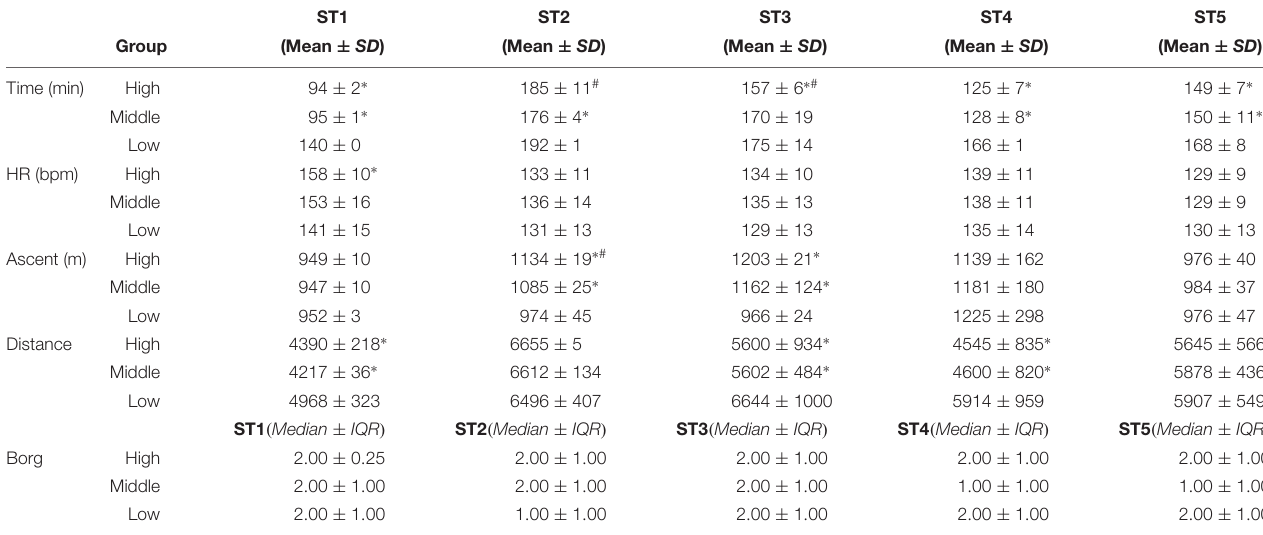
TABLE 1 | Descriptive data regarding the ski route, heart rate, and perceived exhaustion of the recreational ski mountaineers during 5 days of ski mountaineering [Ski Tour 1 (ST1) to Ski Tour 5 (ST5)]. ST1